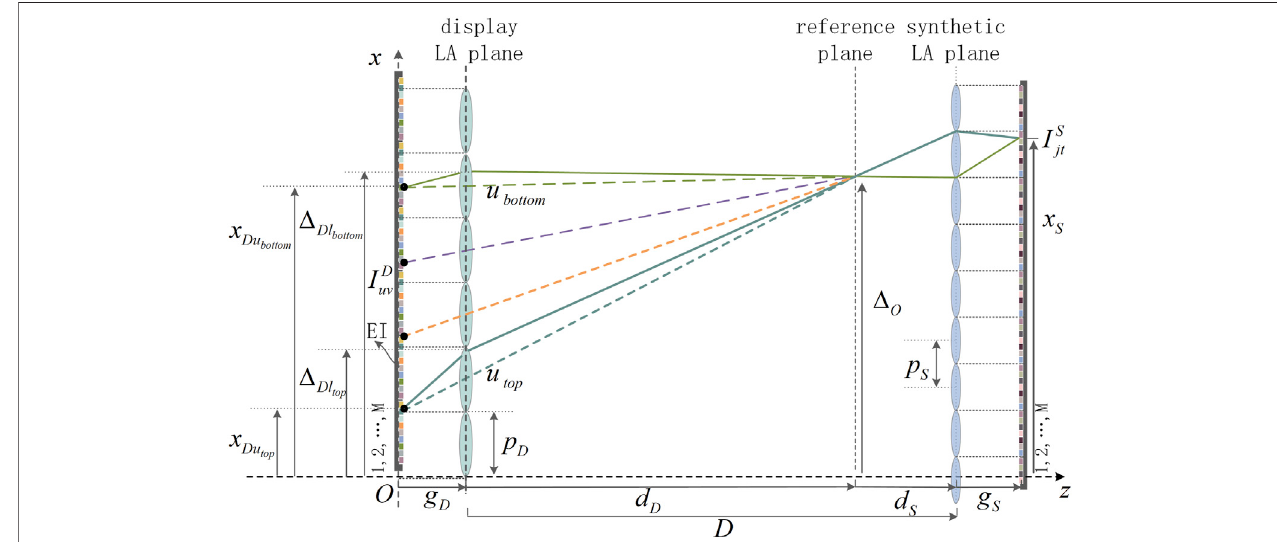
FIGURE 7 | Principle of the average SPOC algorithm.